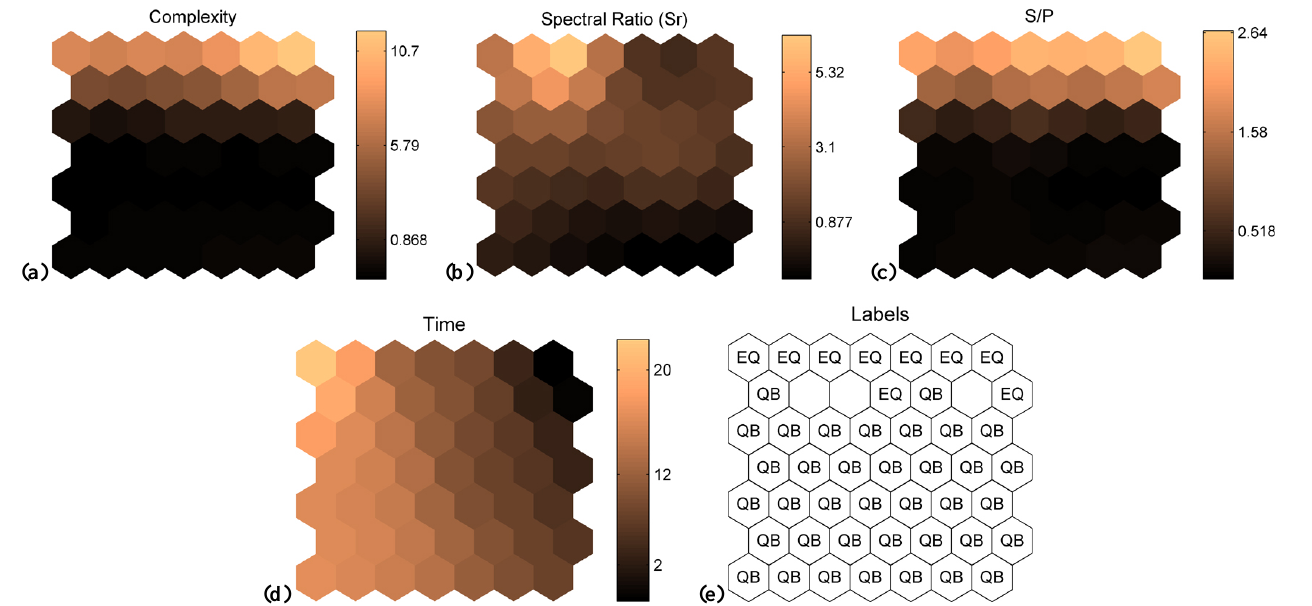
Fig. 2. SOM Visualization of predictions and data (7 × 7 map size). Component planes: (a) complexity, (b) spectral ratio (Sr), (c) S/P ratio, (d) time and (e) map unit labels. In Fig. 1e QB and EQ represent quarry blasts and earthquakes, respectively. Unlabeled cells could not clustered by the method. Five figures have connection by position; the hexagon in a certain position corresponds to the same map unit in each figure. The lightness of the colors increases with indicator value. Two components, complexity and S/P ratio have a strong correlation with the label node